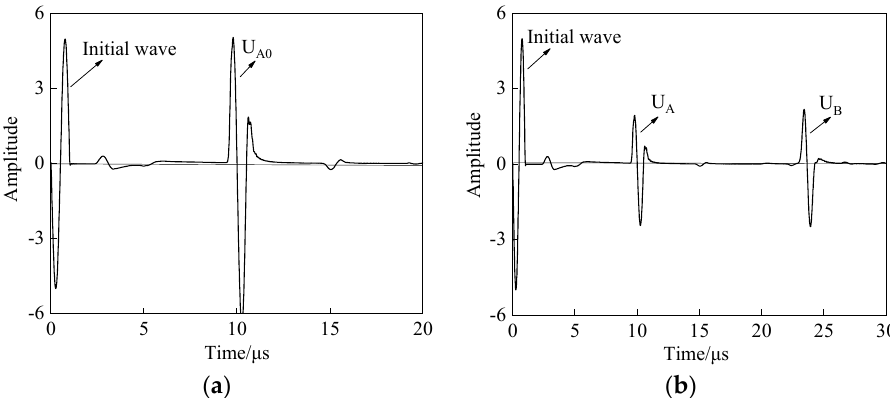
Figure 6. Received waveform of the same 13 mm-thick polymethyl methacrylate (PMMA) and 10 mm-thick EPDM material (1 MHz): ( a ) the reflection wave from the bottom of the buffer with simulation; ( b ) the reflection wave from the surface and bottom of the sample with simulation.